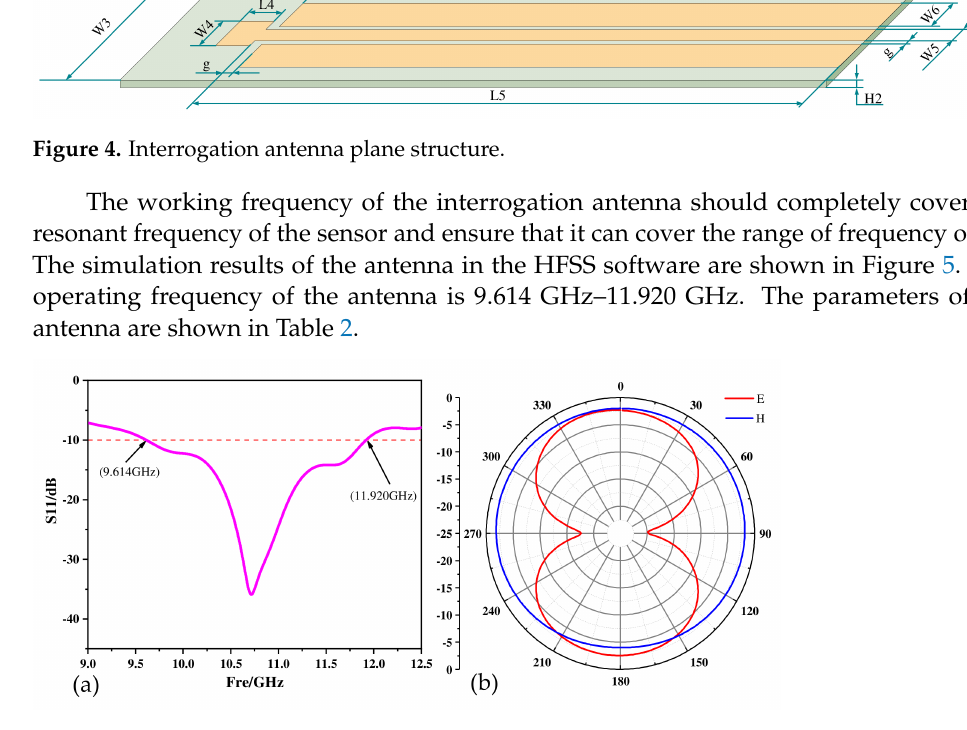
Figure 5. ( a ) Antenna working frequency band, ( b ) antenna pattern. Table 2. Inquiry antenna structure